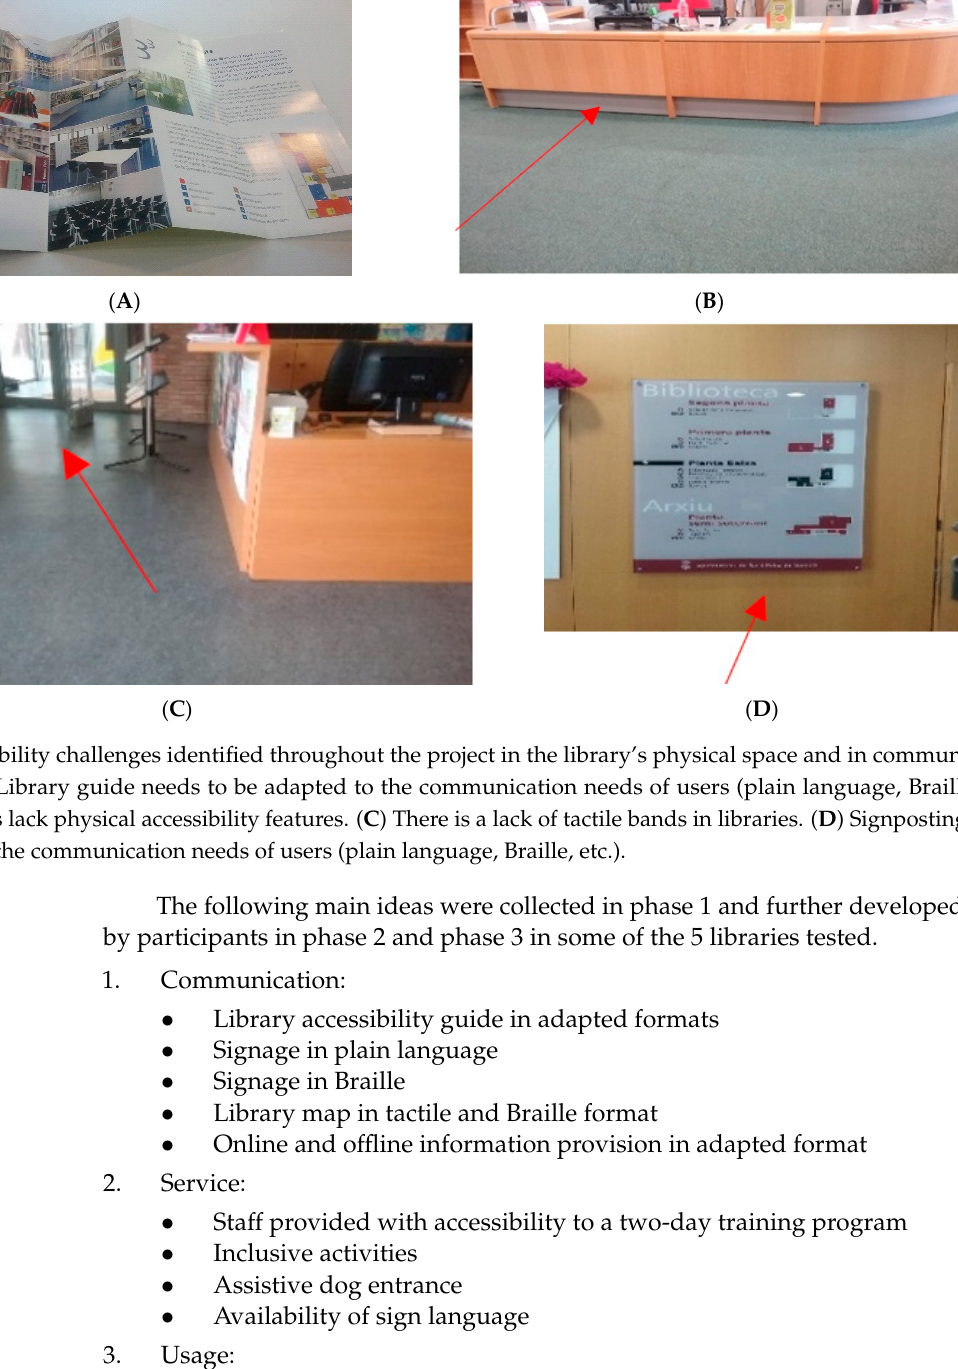
7 of 15 Figure 3. ( A ) Sign language displayer for library staff implemented in all the libraries. ( B ) Acquisition of a huge portfolio of books in plain language for students with intellectual disabilities. ( C ) Podotactile bands implemented in libraries for blind students. ( D ) Signage posting adapted to Universal Design standards to the communication needs of users (plain language, contrasting colours, etc.). The ideas arising in Phase 1 that were deemed both good and feasible were devel- oped by the library managers with the support of the Girona Provincial Council and then tested by our study participants in phases 2 and 3. Figure 4 below shows examples of adaptations made to communication and usage encounters. By the fifth focus group, the brainstorming process had been exhausted [43] and failed to produce new ideas. The following main ideas were collected in phase 1 and further developed and tested by participants in phase 2 and phase 3 in some of the 5 libraries tested. 1.